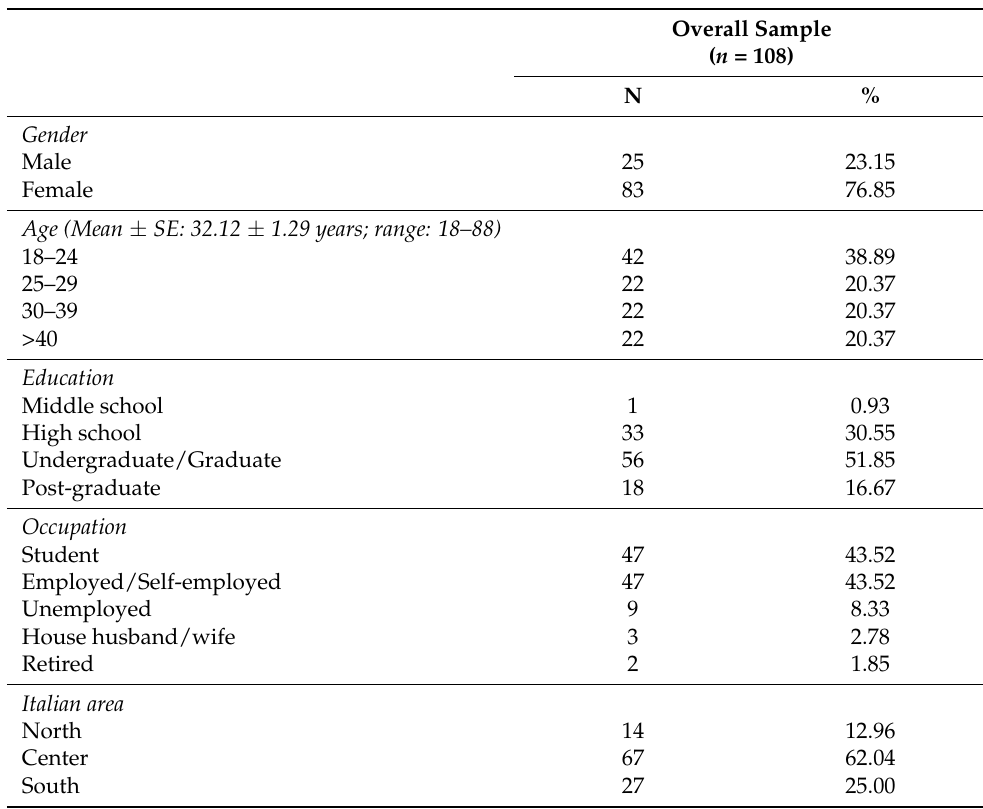
Table 2. Demographic characteristics of the